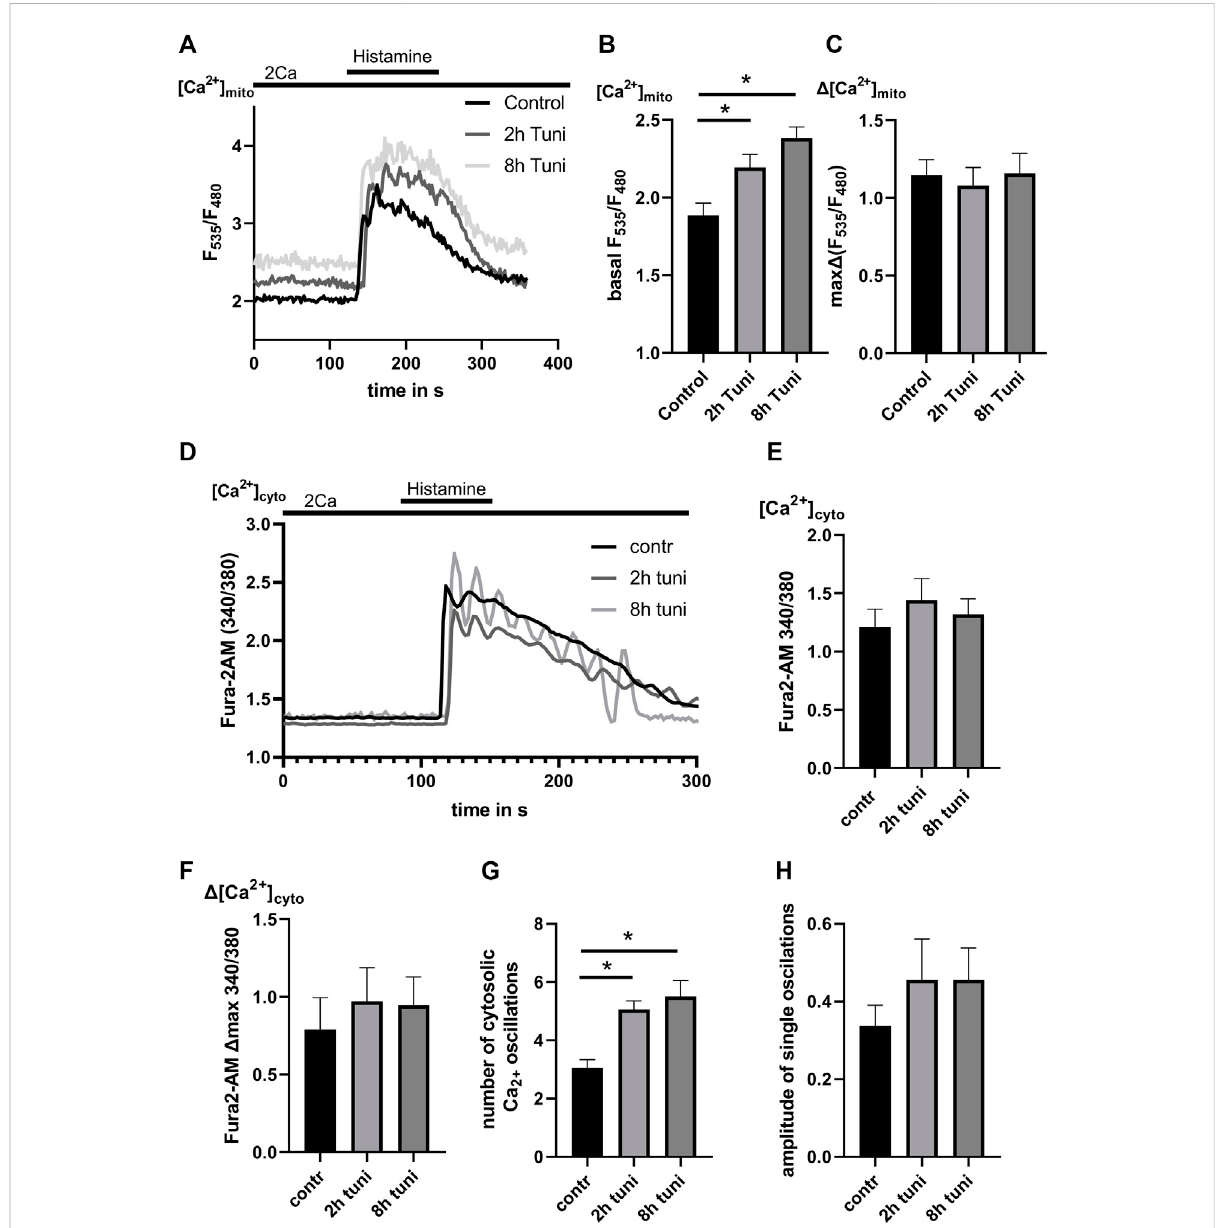
ER-stress leads to increased basal [Ca 2+ ] mito and IP 3 generating agonist induced oscillations of [Ca 2+ ] cyto . (A) HeLa cells stable expressing the mitochondrial targeted genetically encoded Ca 2+ sensor 4mtd3cpv were used. Representative [Ca 2+ ] mito traces upon histamine induced [Ca 2+ ] ER release of control HeLa cells or HeLa cells treated with 0.6 µM tunicamycin for 2 h or 8 h. (B) Bar graphs (MEAN ± SEM) represent basal [Ca 2+ ] mito levels of control HeLa cells or HeLa cells treated with tunicamycin for 2 h or 8 h. (C) Bar graphs represent [Ca 2+ ] mito uptake in response to histamine treatment of control HeLa cells ( n = 4/8/40) or HeLa cells treated with tunicamycin for 2 h ( n = 4/8/45) or 8 h ( n = 4/8/48). (D) HeLa cells labeled with the cytosolic Ca 2+ indicator Fura-2 AM were used. Representative [Ca 2+ ] cyto traces upon histamine induced [Ca 2+ ] ER release of control HeLa cells or HeLa cells treated with tunicamycin for 2 h or 8 h. (E) Bar graphs represent basal [Ca 2+ ] cyto levels of control HeLa cells or HeLa cells treated with tunicamycin for 2 h or 8 h. (F) Bar graphs represent [Ca 2+ ] cyto uptake in response to histamine treatment of control HeLa cells or HeLa cells treated with tunicamycin for 2 h or 8 h. (G) Bar graphs represent the number of [Ca 2+ ] cyto oscillations during histamine induced [Ca 2+ ] ER release of control HeLa cells or HeLa cells treated with tunicamycin for 2 h or 8 h. (H) Bar graphs represent the amplitude of [Ca 2+ ] cyto oscillations during histamine induced [Ca 2+ ] ER release of control HeLa cells ( n = 3/6/85) or HeLa cells treated with tunicamycin for 2 h ( n = 3/6/98) or 8 h ( n = 3/6/105). * p < 0.05 vs. respective control conditions carried out with one-way ANOVA with Tukey corrected posthoc